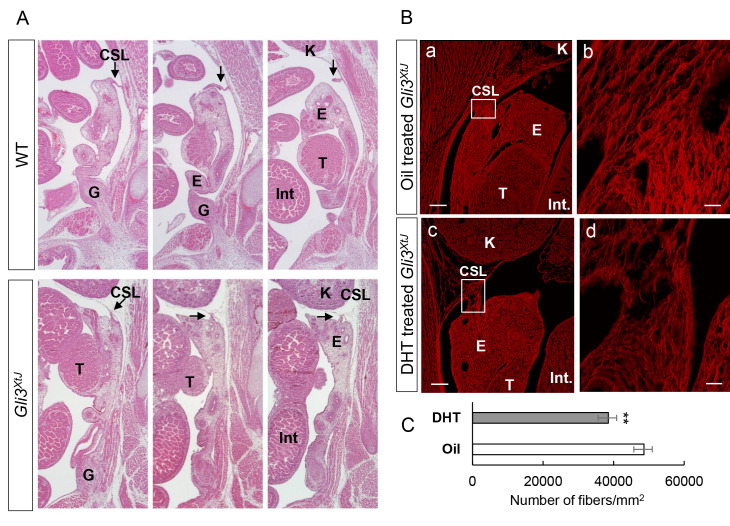
Cranial suspensory ligaments (CSL) persist in Gli3XtJ embryos and degrade in response to exogenous DHT.A) H&E stain of serial sagittal sections from wild type (n = 5) and Gli3XtJ mutant (n = 5) embryos at E16.5. Arrows denote cranial suspensory ligaments (CSL), epididymis (E), intestine (Int), kidney (K), testis (T) and gubernaculum (G). B) Pregnant dams were treated daily with sesame oil or DHT (1 mg/kg body weight), starting on E12.5 until the embryos were harvested at E16.5. Oil treated (a,b) (n = 4) and DHT treated (c,d) (n = 4) Gli3XtJ urogenital sections were stained with picrosirius red to detect mature collagen fibers. The enlarged images (b,d) are taken from boxed regions in low magnification image (a,c). Scale bar: (a,c) = 100 μm and (b,d) = 25 μm. C) Total collagen density was determined by measuring the number of collagen fibers within a region of interest representing the total cross-sectional area of the CSL. Results are represented as mean ± SEM. Student’s t-test, **: p<0.01.